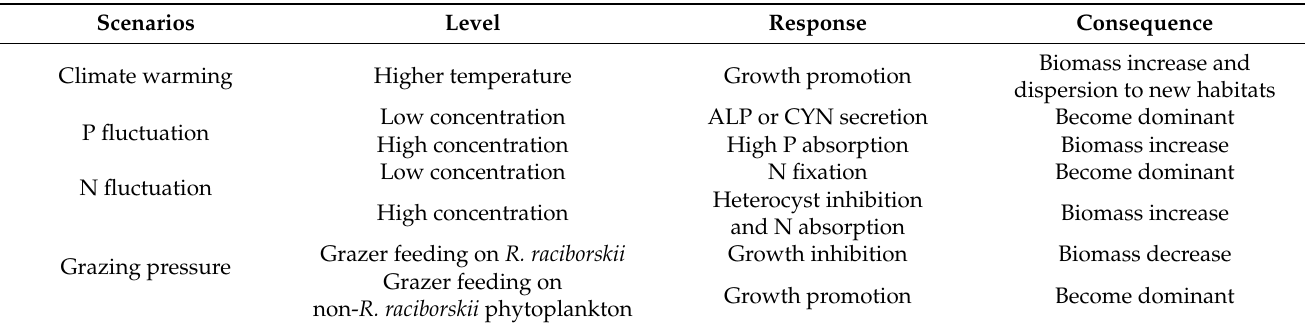
Table 3. Adaptation of R. raciborskii to different ecological